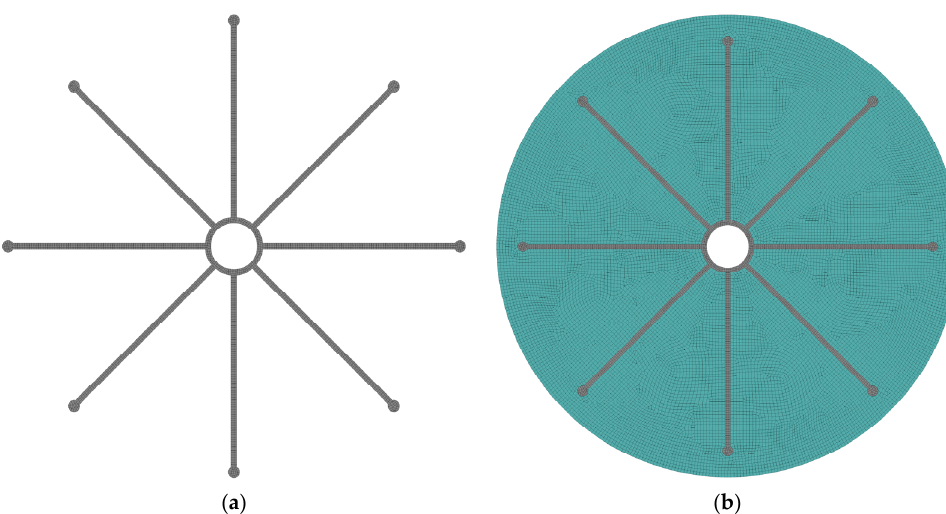
Figure 5. Mesh of the tube with 8 fins: ( a ) without frost, ( b ) entirely covered by